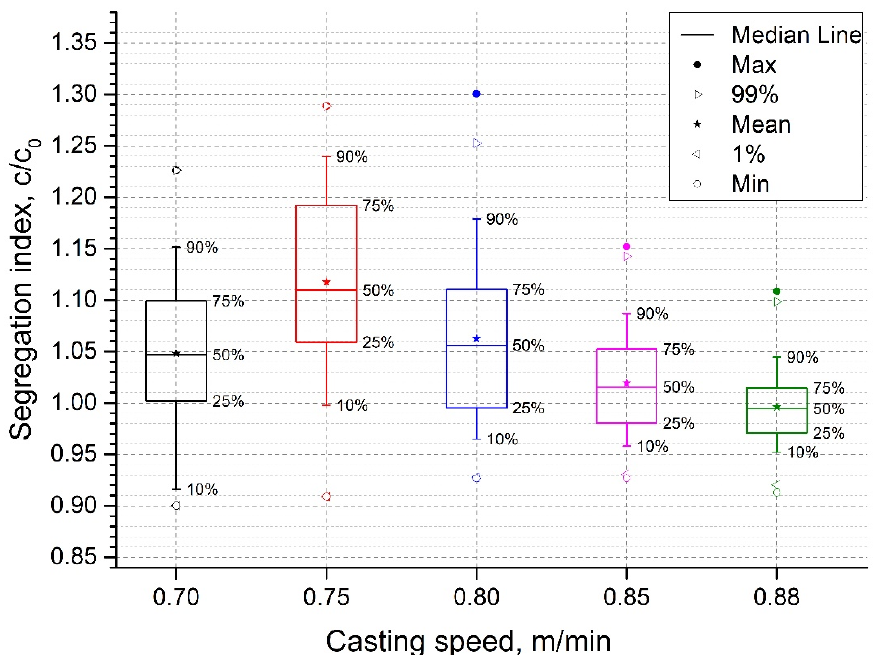
Figure 9. Statistical distribution of the bloom center carbon segregation level at different casting conditions for steel GCr15.